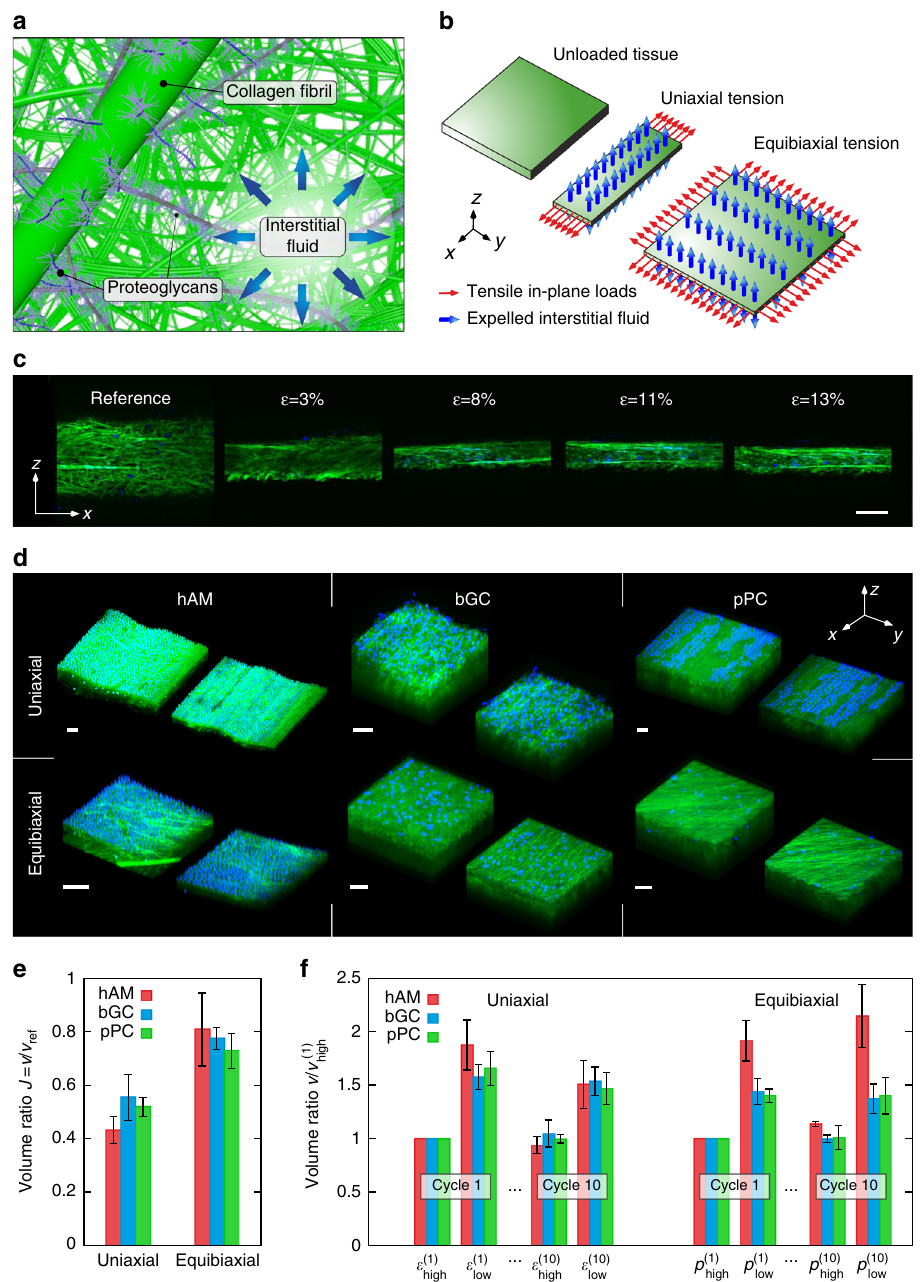
Fig. 1 Volume changes in soft collagenous membranes. a Illustration of extracellular matrix components mainly responsible for the mechanical behavior of soft collagenous tissues: collagen fi brils and fi bers, proteoglycans carrying negative charges and interstitial fl uid. b Schematics of the response to in-plane mechanical forces: unloaded and deformed tissues in uniaxial (UA) and equibiaxial (EB) tension. c Thickness reduction of bovine Glisson ’ s capsule (bGC) sample in UA tension with increasing applied elongation ε ; cross-sectional multiphoton microscopy (MPM) images of collagen ( green ) and stained cell nuclei ( blue ), taken close to the lateral edge of a sample. Scale bar : 100 μ m. d MPM stacks in reference and deformed state demonstrate strong thickness reduction at ~10% in-plane elongation. Scale bars : 50 μ m. e Volume reduction J = λ 1 λ 2 λ 3 in UA and EB tension from combined macroscopic (human amnion (hAM): n = 9, bGC: n = 5, porcine pericardium (pPC): n = 5) and MPM (hAM: n = 3, bGC: n = 3, pPC: n = 3) data. Reported is mean and standard deviation ( error bar ). f Volume change during cyclic loading (10 cycles) in UA (strain states ε high = 12%, ε low = 0%) and EB (in fl ation pressure states p high = 4 kPa (hAM)/55 kPa (bGC, pPC), p low = 0.1 kPa) con fi gurations. The data are normalized with respect to the volume at ε high and p high in the fi rst cycle. Reported is mean and standard deviation ( error bar ) for hAM (macroscopic: n = 7, MPM: n UA = 3, n EB = 4), bGC (macroscopic: n = 5, MPM: n = 3) and pPC (macroscopic: n = 5, MPM: n = 3). Some of the hAM data include information from refs. 10, 23,